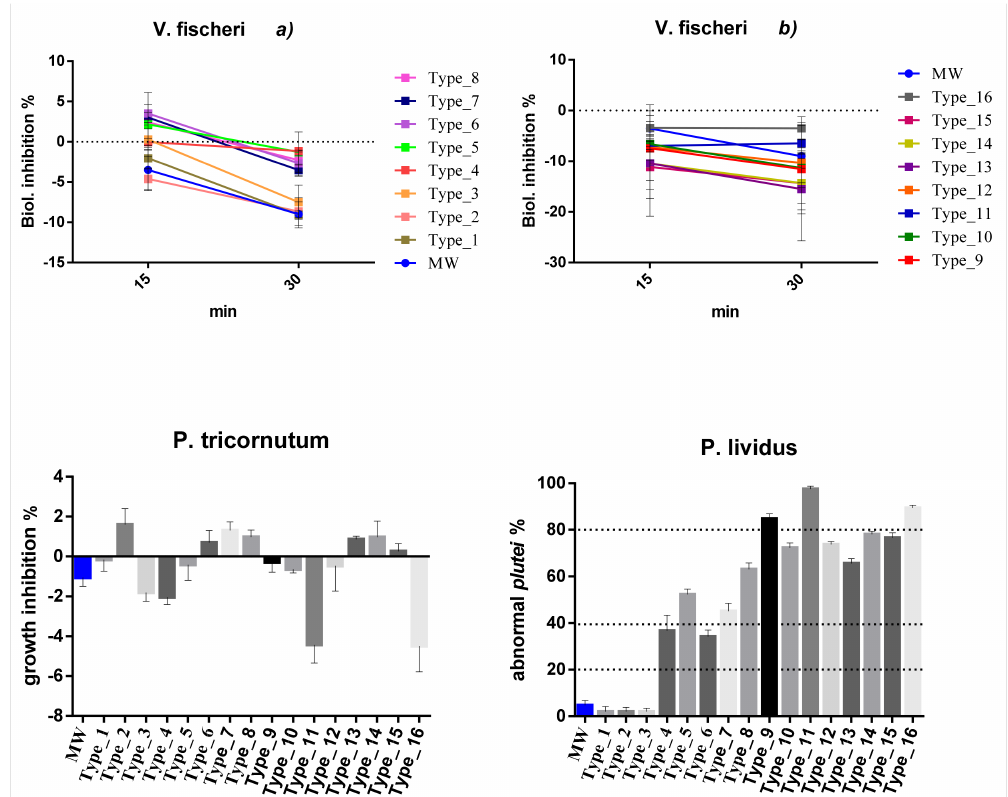
Figure 1. Mean percentage of effects in tested species for each packaging type. Results are expressed in percentage (%). Standard deviation is represented. Negative values represent stimulation while positive values imply inhibition. MW = marine water (negative control, blue colour). Data are reported under standard pH conditions (8.10). Effect (>20%) was recorded only in echinoderm larvae. Echinoderm data were corrected with Abbott’s correction: (X − Y)/(100 − Y)*100, where X is the effect cause by the sample and Y is the effect cause by the control. Leachate dilution: 100% for echinoderms and algae; 90% for